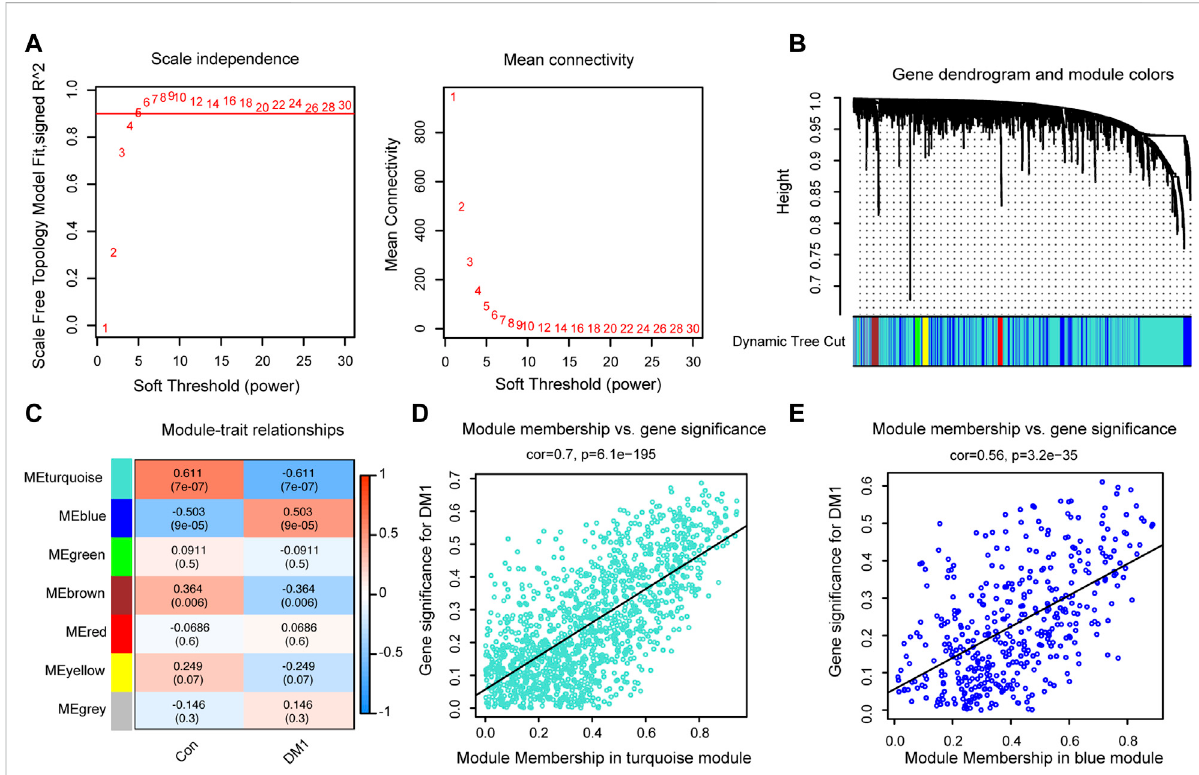
FIGURE 1 Identi fi cation autophagy-related key modules via Weighted gene co-expression network analysis (WGCNA). (A) Diagrams showing analysis of networktopologybasedonvarioussoft-thresholdingpowers. (B) GeneclusteringdendrogramandmoduleassignmentbyWGCNA. (C) Module-trait relationships between seven key modules and clinical traits. Scatterplot of module membership (MM) versus gene signi fi cance (GS) for DM1 in the network of turquoise (D) and blue modules (E) . Con, control; DM1, myotonic dystrophy type